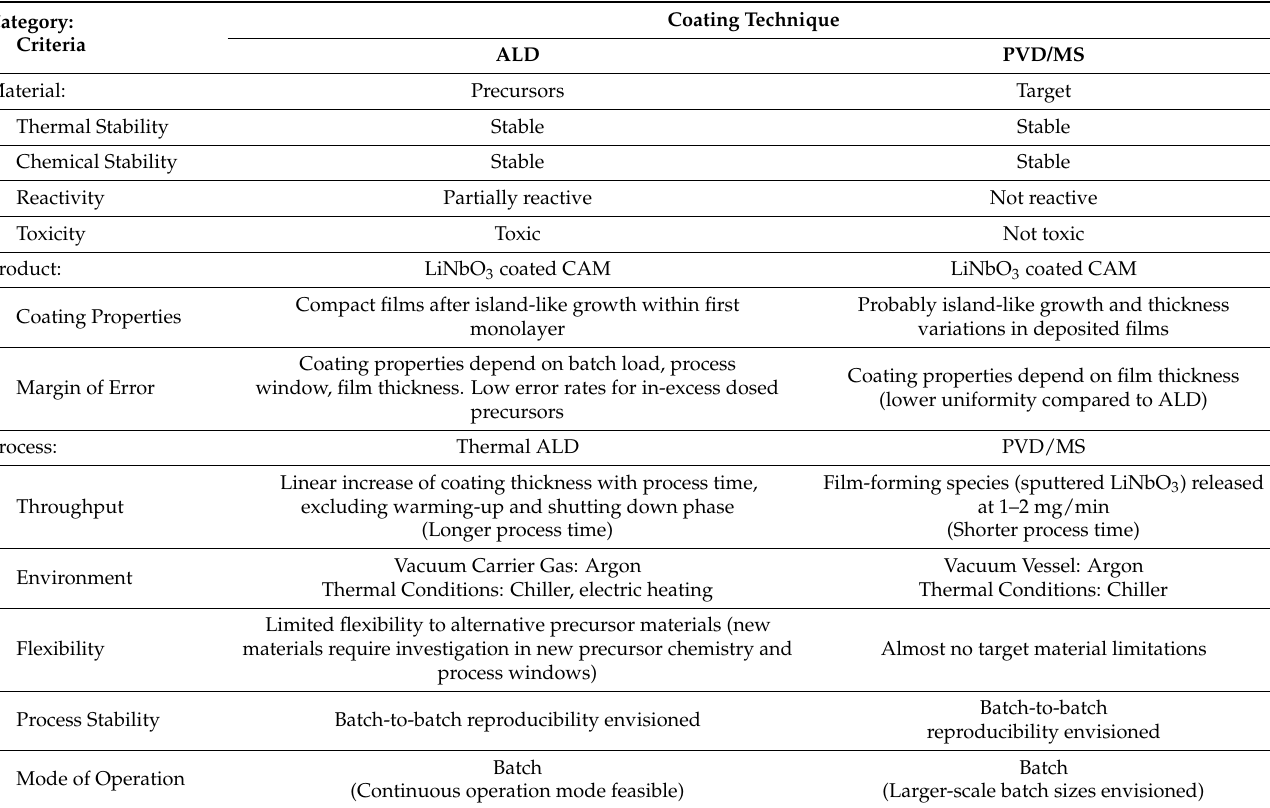
Table 9. Technical Assessment of ALD and PVD/MS Coating